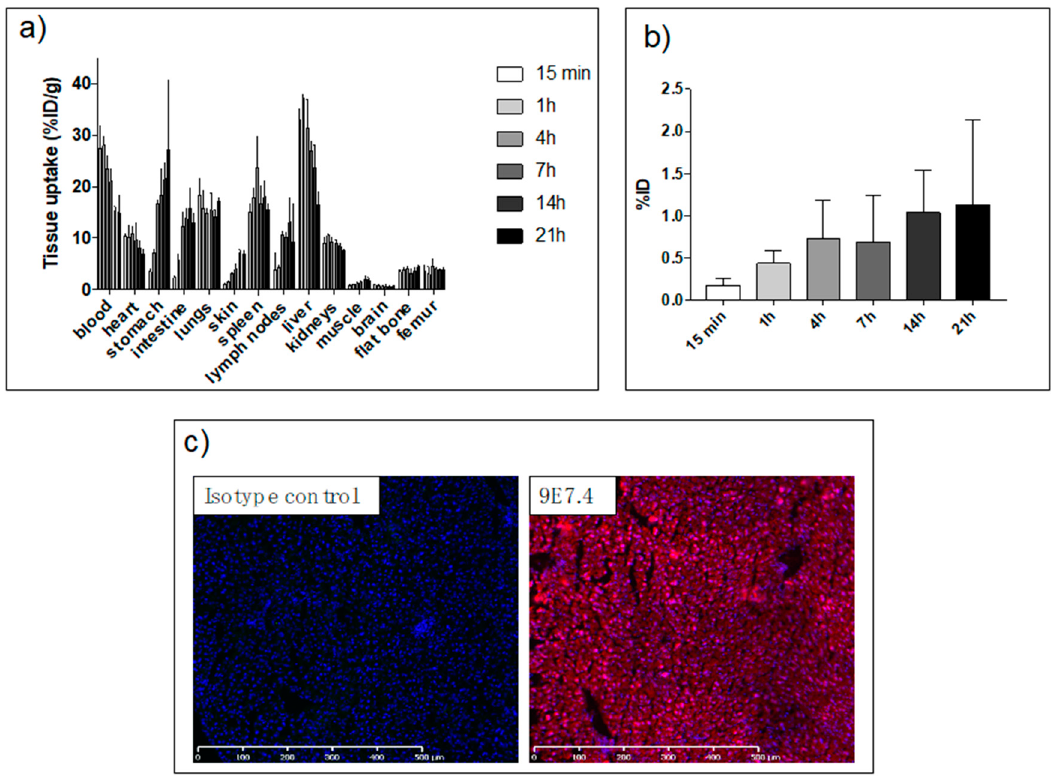
Figure 2. Biodistribution data analysis of the immunoconjugate 211 At-9E7.4 and immunofluorescence data of CD138 expression on liver tissue. ( a ) Biodistribution data of 211 At-9E7.4 mAb. Three animals were sacrificed at each time point. Data are expressed at the percentages of injected dose per gram of tissue (%ID/g). Means and SD are depicted. ( b ) Biodistribution data of 211 At-9E7.4 mAb in thyroid. Three animals were sacrificed at each time point. As it is difficult to collect the thyroid, the neck was collected, counted and the data are expressed at the percentages of injected dose (%ID). Means and SD are depicted. ( c ) Immunofluorescence analysis of liver section with 9E7.4 or isotype control IgG2a, κ labeling with Alexa Fluor 647(pink). Nuclei are visualized with DAPI (blue). Scans were performed using a slide-scanner Nanozoomer (Hamamatsu ® ).